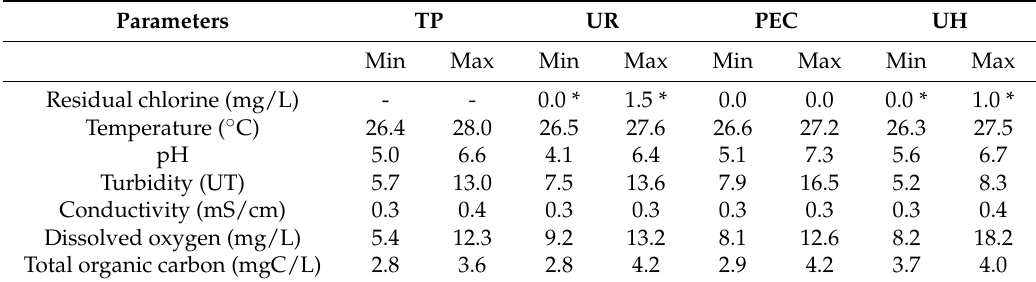
Table 1. Water physical-chemical data from the sampling sites with the minimum and maximum values obtained from the collection